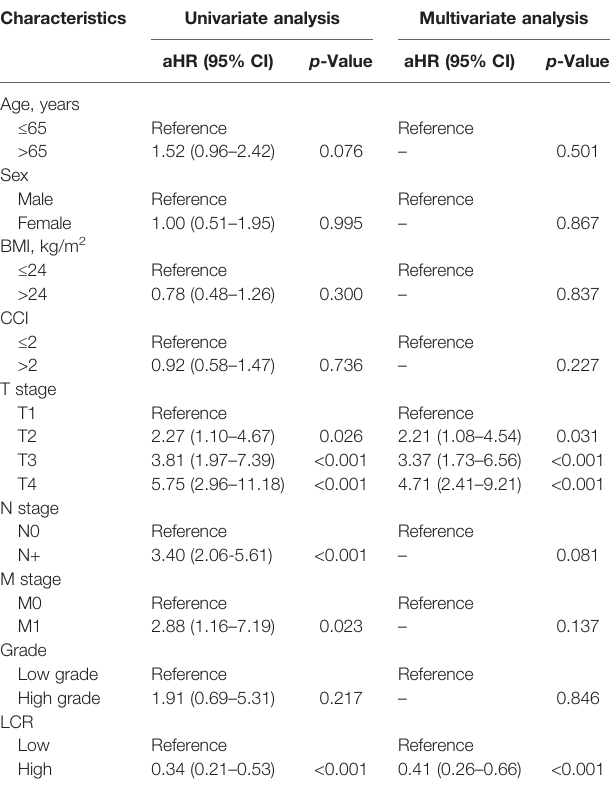
TABLE 2 | Relative risk of overall survival (OS).